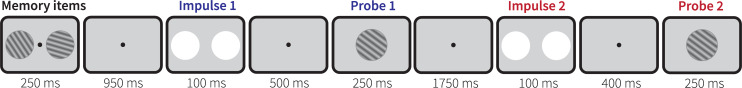
Procedure Generalization 2/Experiment 2.Participants knew which memory item would be probed first. Note the long break after Probe 1.